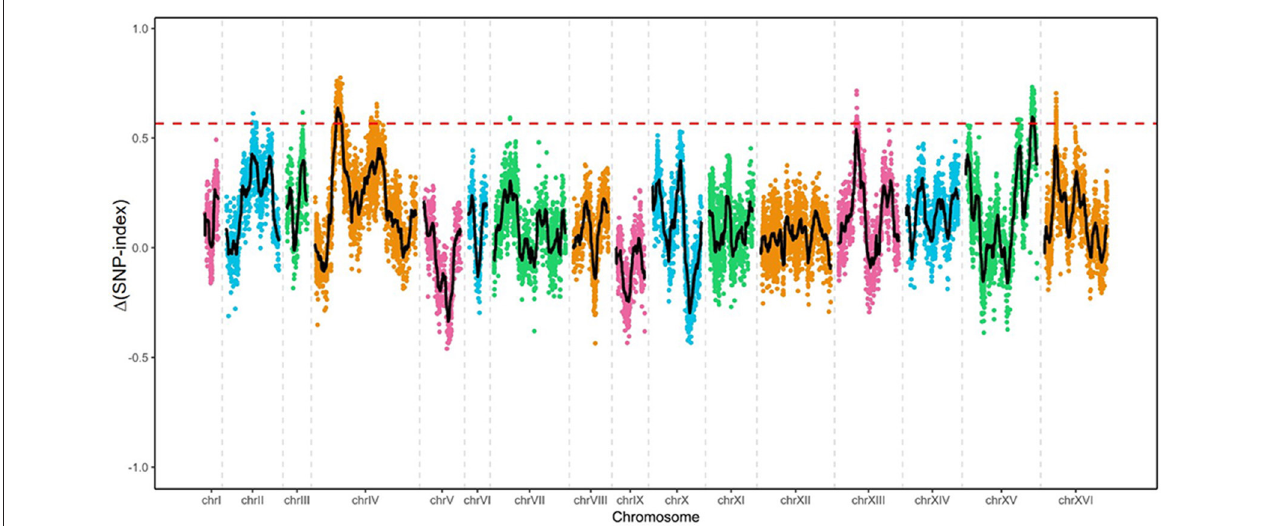
FIGURE 5 | Mapping of the loci involved in near-freezing temperature tolerance by pooled-segregant whole-genome sequence analysis. The X-axis indicates the chromosomes position; Y-axis indicates the 1 (SNP-index) values. The 1 (SNP-index) was the difference between SNP-index of “High-tolerance pool” and that of “Low-tolerance pool.” Black lines show the average 1 (SNP-index) values, as determined using a sliding window analysis with 50kb window size and 200 bp increment. Red dotted line shows the threshold (0.5660) of 1 (SNP-index).